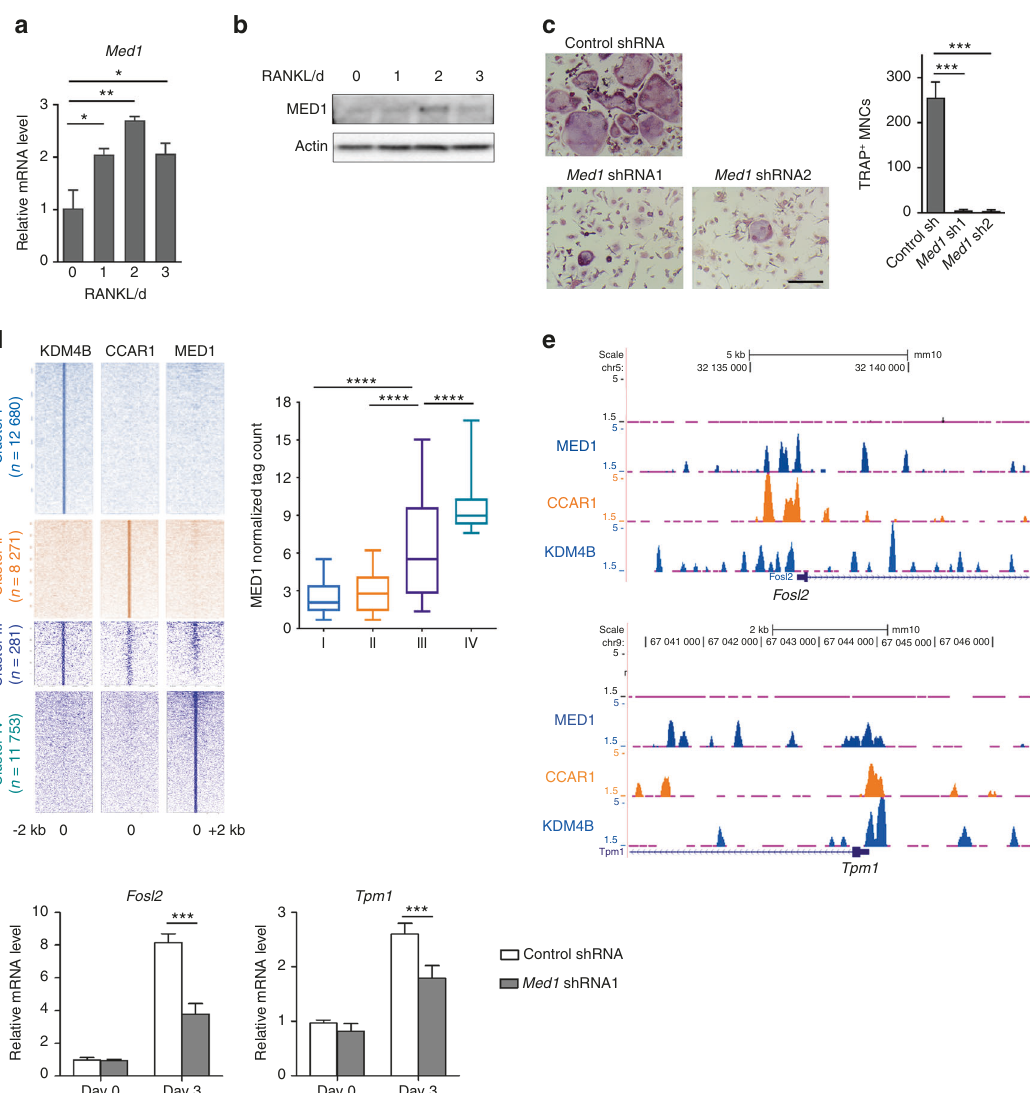
Fig. 4 The KDM4B – CCAR1 – MED1 axis is required for osteoclastogenesis. a , b MED1 expression during osteoclast differentiation. qRT-PCR ( a ) and immunoblot ( b ) results. c TRAP staining of BMMs expressing either control shRNA or Med1 shRNA. Scale bar, 75 μ m. d Heatmap of normalized tag densities on KDM4B, CCAR1, and MED1 peaks (2 kb up/downstream of the peak centers) (left panels). Quanti fi cations of MED1 tag counts are shown in the box plots (right panel). The boxes enclose the 25th to 75th percentile values. The whiskers extend to the 10th and 90th percentiles. The central horizontal bar indicates the median. **** P < 0.000 1 (Kolmogorov – Smirnov test). e Representative UCSC Genome Browser tracks showing co-occupancy of KDM4B, CCAR1, and MED1 at Fosl2 and Tpm1 . f mRNA expression levels of Fosl2 and Tpm1 in cells expressing control shRNA or Med1 shRNA. The data are presented as the mean ± SD values of three independent experiments [one-way ANOVA in ( a , c )]. * P < 0.05; ** P < 0.01; *** P < 0.001. See also Supplementary Fig.